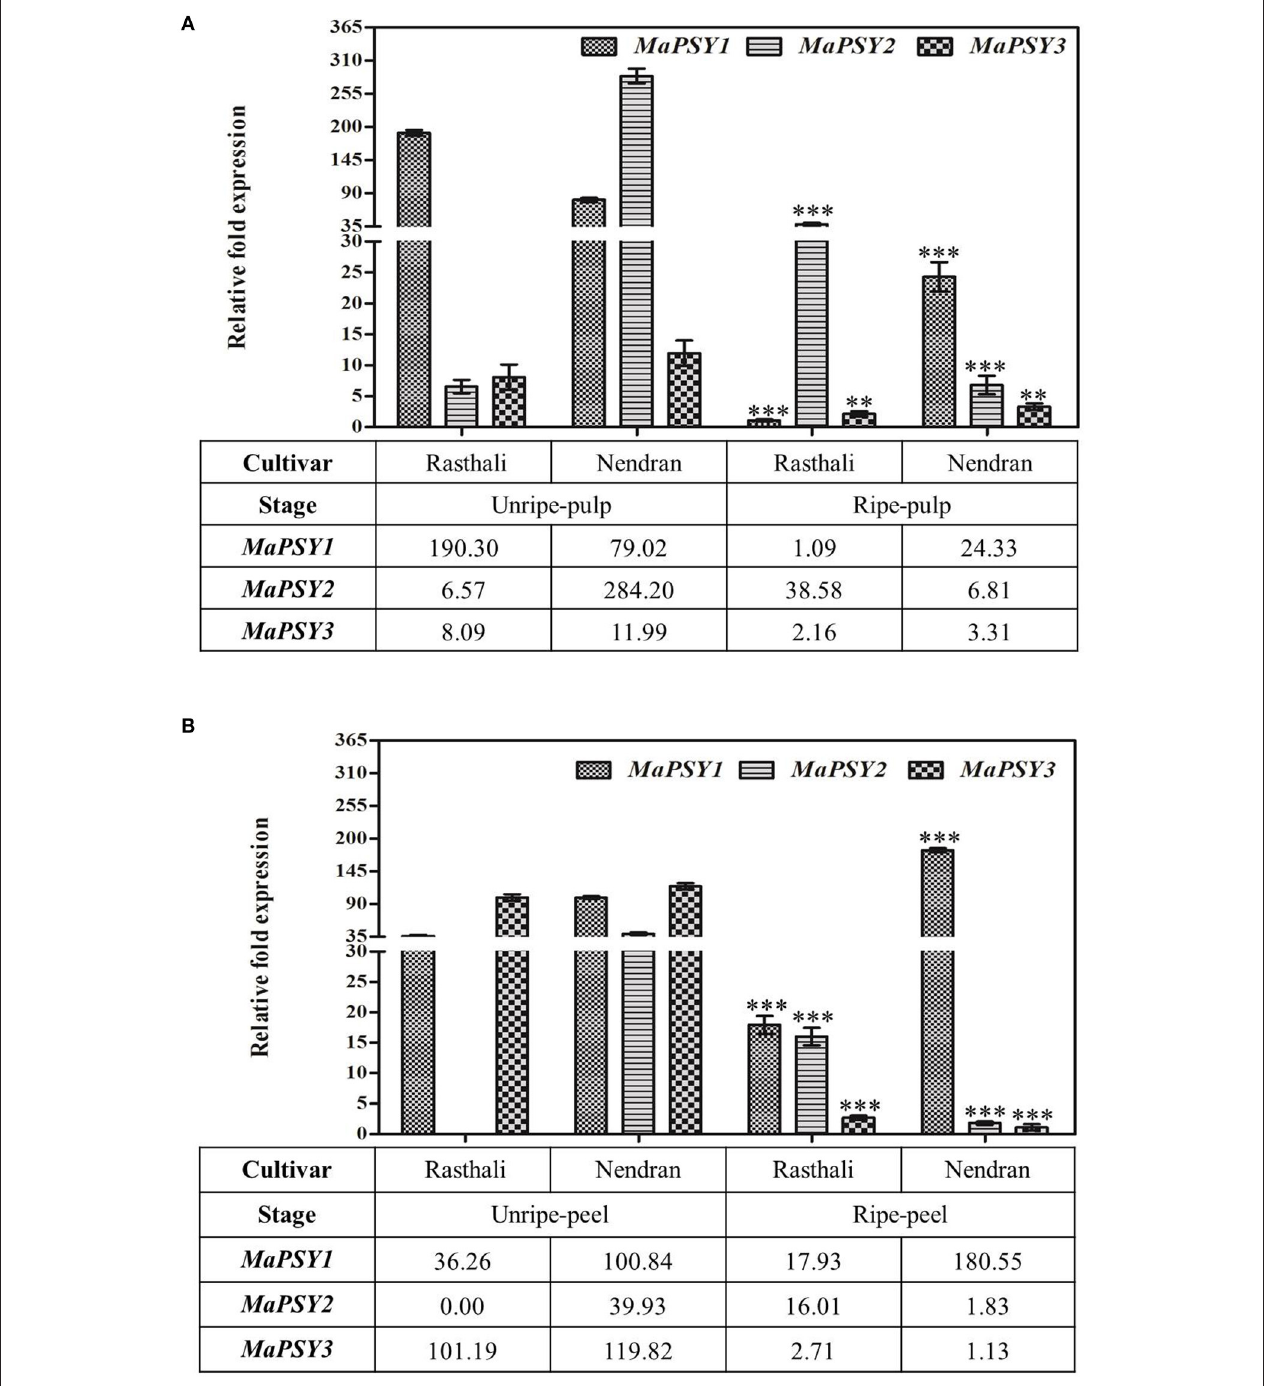
FIGURE 3 | Spatiotemporal real-time PCR expression analysis of PSY genes in banana fruit tissues. Transcript expression profiles are presented in unripe/ripe -pulp (A) and -peel (B) of Rasthali and Nendran cultivars. The gene expression was normalized with reference to actin1 taken as internal control. Bars denote mean fold expression as compared to the lowest expressing gene in the group of samples ± SD. Statistical analysis was performed using Student’s paired t -test. Statistical significance was checked at P ≤ 0.05–0.001 (** P ≤ 0.001; *** P ≤ 0.0001) with respect to the unripe- versus ripe-pulp/peel of Rasthali and Nendran.